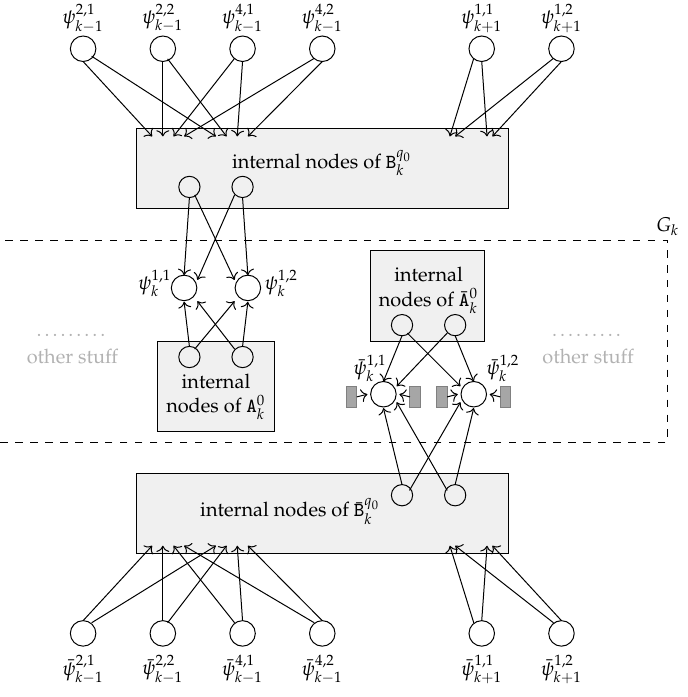
Figure 6. For k > 1, the in-neighborhood of nodes ψ 1,1